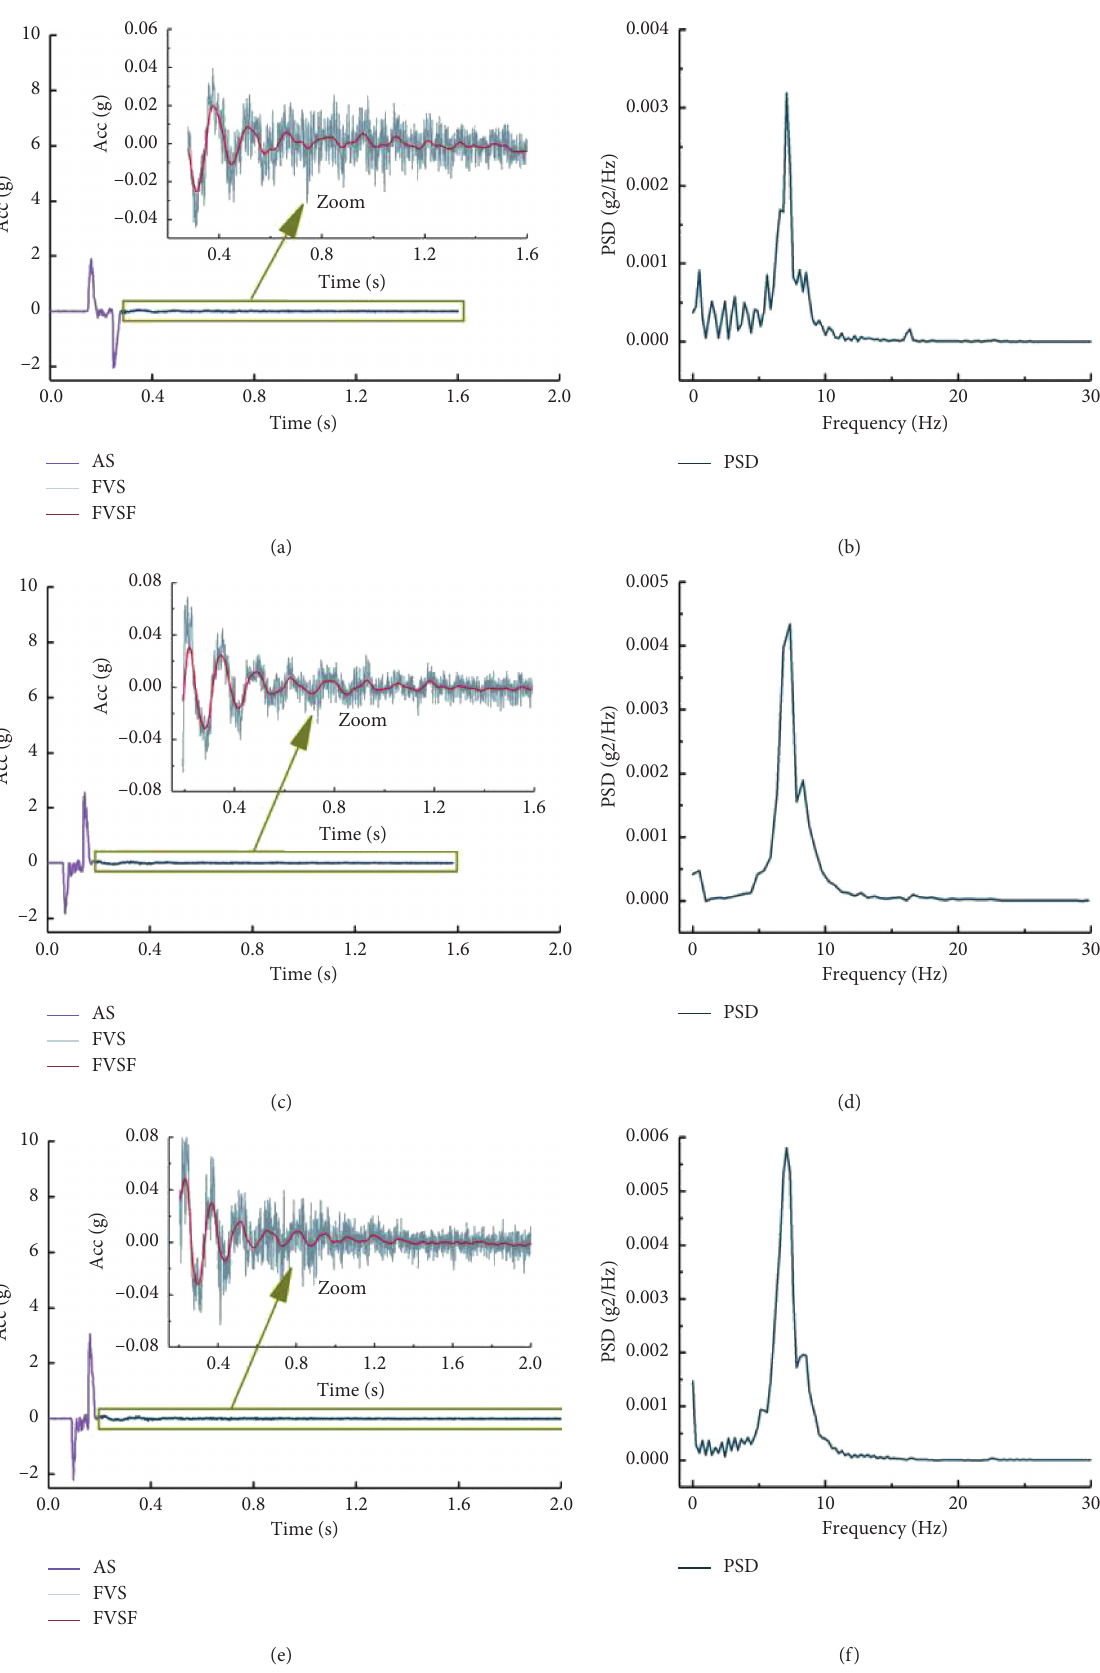
Figure 7: Residual vibration signal and PSD of FVSF for triangular move profile impact with V a − � 2g; (c) and (d) a − � 2.5 g; (e) and (f) a − �